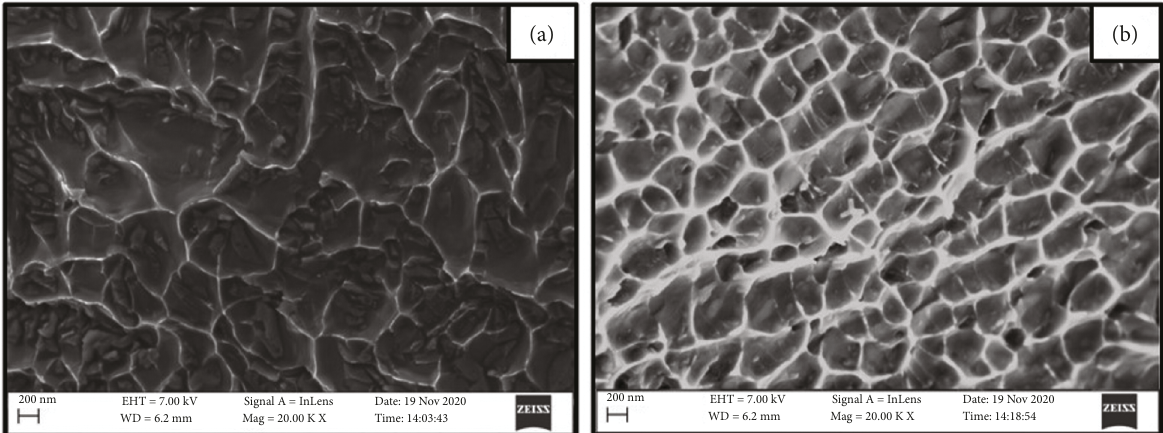
Figure 8: Fracture surface of (a) Al 7075 alloy matrix and (b) Al 7075/9 wt. (%) borosilicate glass powder-reinforced composite.